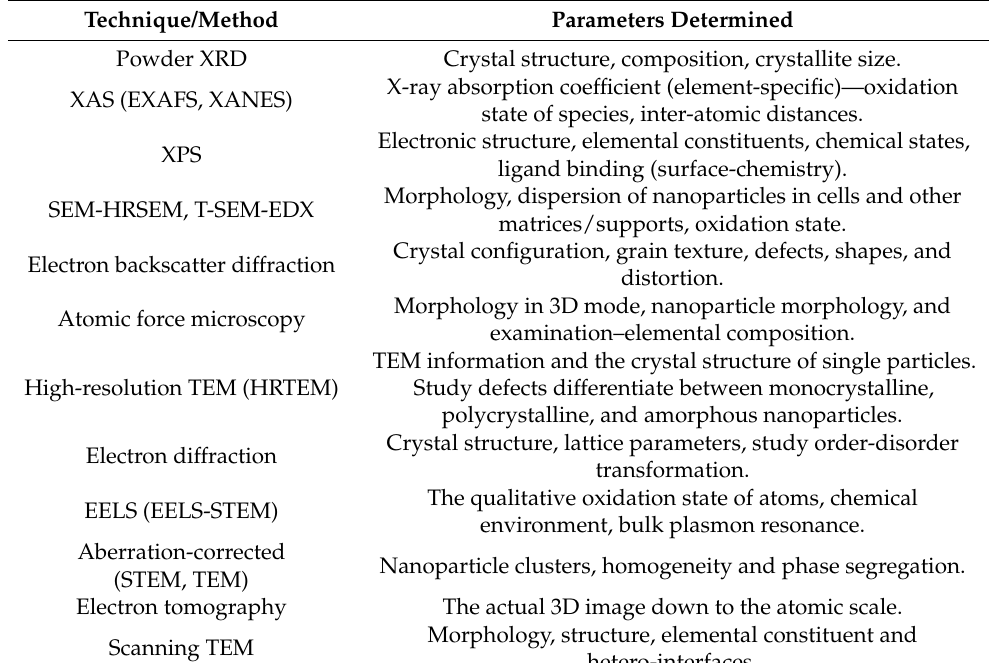
Table 6. Summary of characterisation techniques